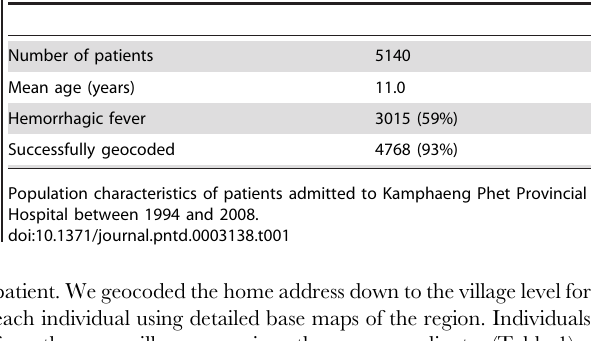
Table 1. Population